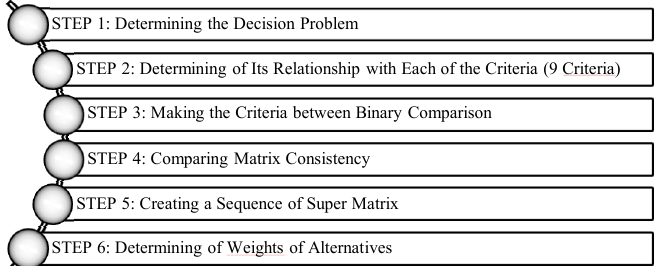
Figure 4. Schematic representation of the analytic network process (ANP) steps.